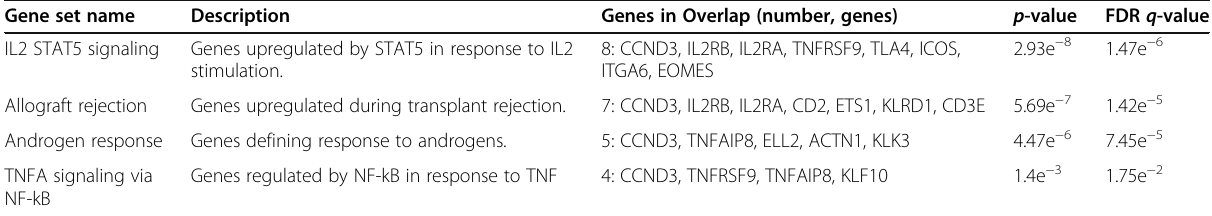
Table 2 Analysis of the overlap of the cured genes with Hallmark annotated sets in